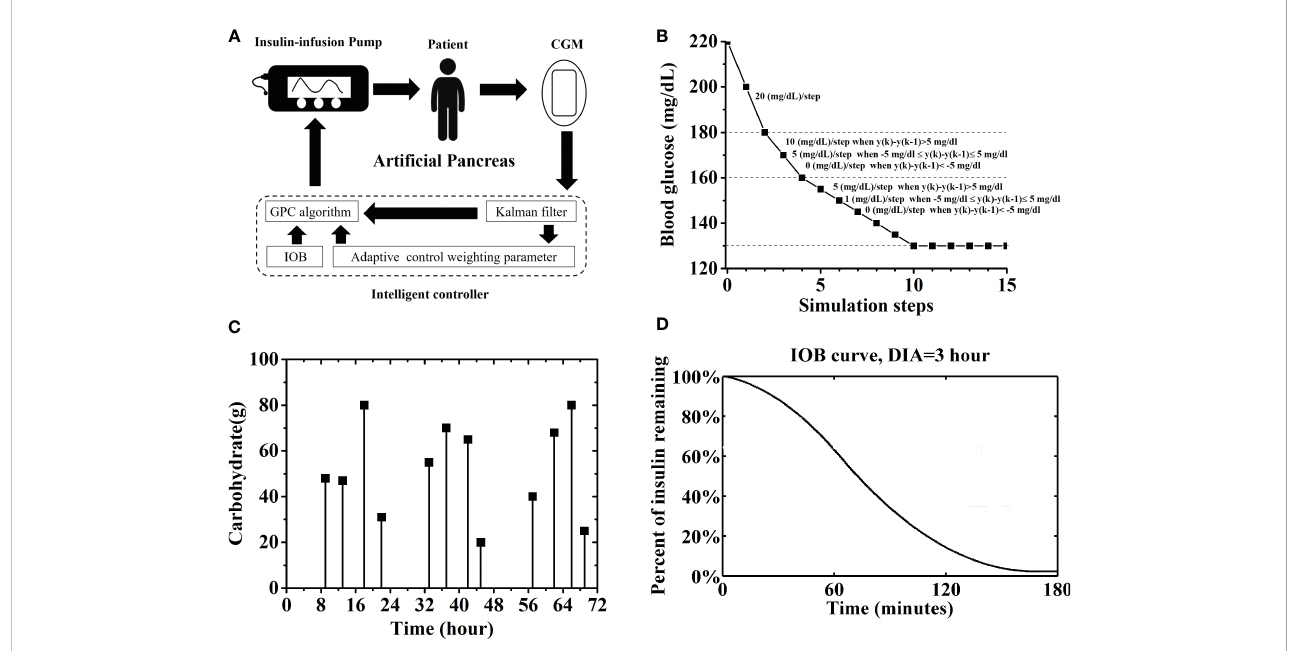
FIGURE 1 (A) Sketch map of an AP system, including a CGM, an insulin pump and an intelligent controller. Here, the intelligent controller was based on general predictive control (GPC) algorithm. A Kalman man fi lter, an IOB calculator and an AW strategy were introduced into the controller. (B) Adaptive reference glucose trajectory. (C) Carbohydrate and time of twelve unannounced meals. (D) IOB curve for prediction the active insulin amount, DIA is set as 3